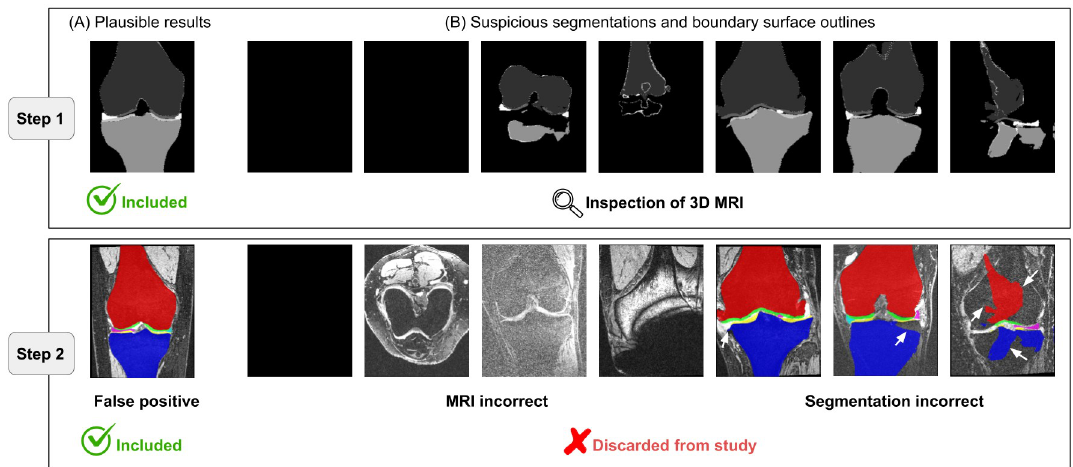
Fig 2. Quality assurance of automated segmentations. Step 1: Segmentation results (outlines) are shown for coronal slices of the MRI. Plausible results (A) are included in this study. For suspicious results (B) the complete 3D MRI is inspected (Step 2). Examples for discarded cases are (from left to right): MRI can not be loaded, wrong MRI orientation, doubtful MRI appearance, MRI artifacts, incorrect menisci segmentation, incorrect bone segmentation, incorrect overall segmentation (incorrect segmentations indicated by white arrows). 1,850 cases which appeared suspicious in Step 1 were identified as false positives in Step 2 and remained included in this